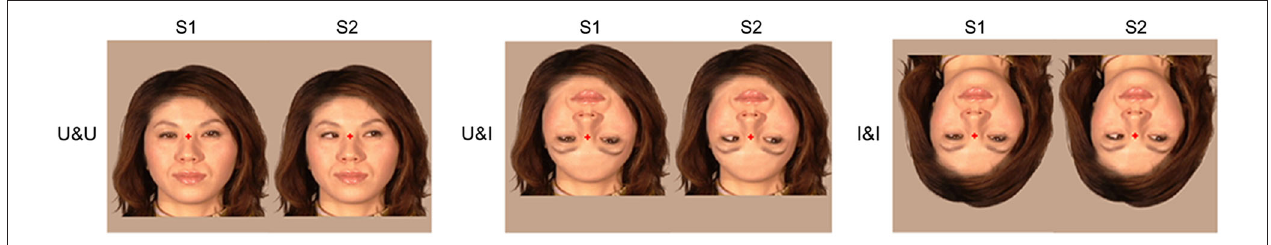
contour and Inverted features, and (3) I&I: inverted contour and Inverted features (adopted from Miki et al., 2011).